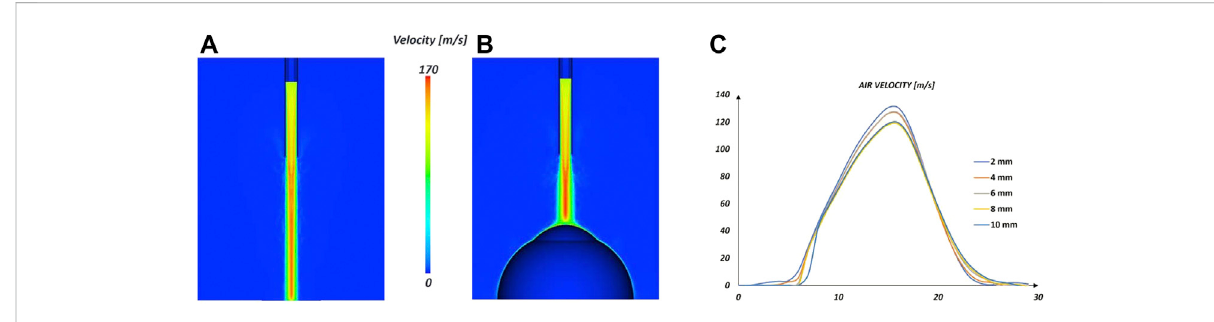
FIGURE 4 Fluid analysis: contour of the air peak velocity in the CFD simulation without the eye shape (A) and with the eye shape (B) . Centerline velocity distribution as a function of distance from the nozzle used to test the fl uid parameters in the case without the eye shape.